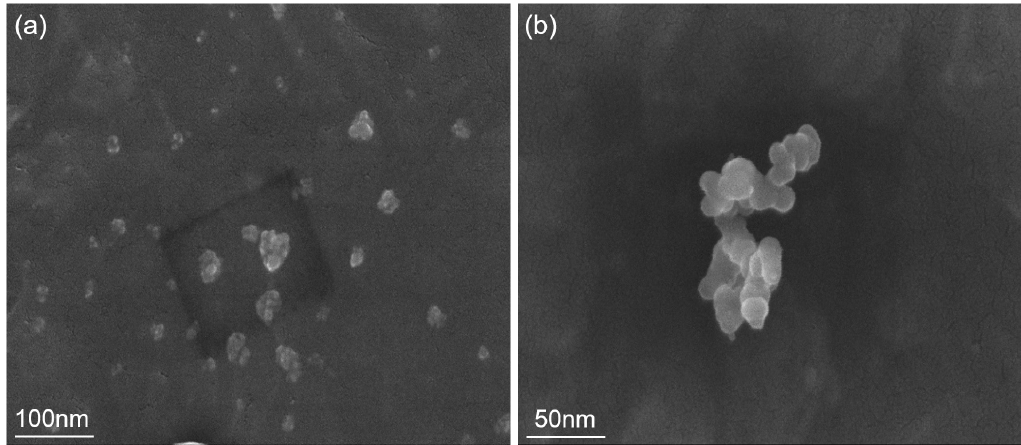
Figure 1: (a) High magnification SEM image of nano-silica; (b) Details of